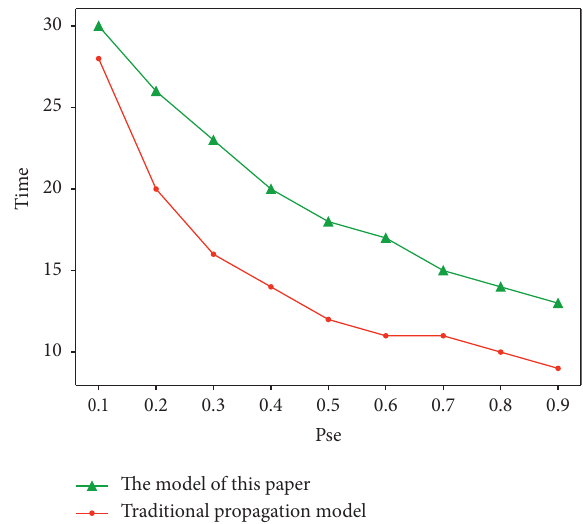
Figure 9: The time required to reach the maximum range of in- formation propagation. Figure 8: System evolution trends when the magnitude of incomes